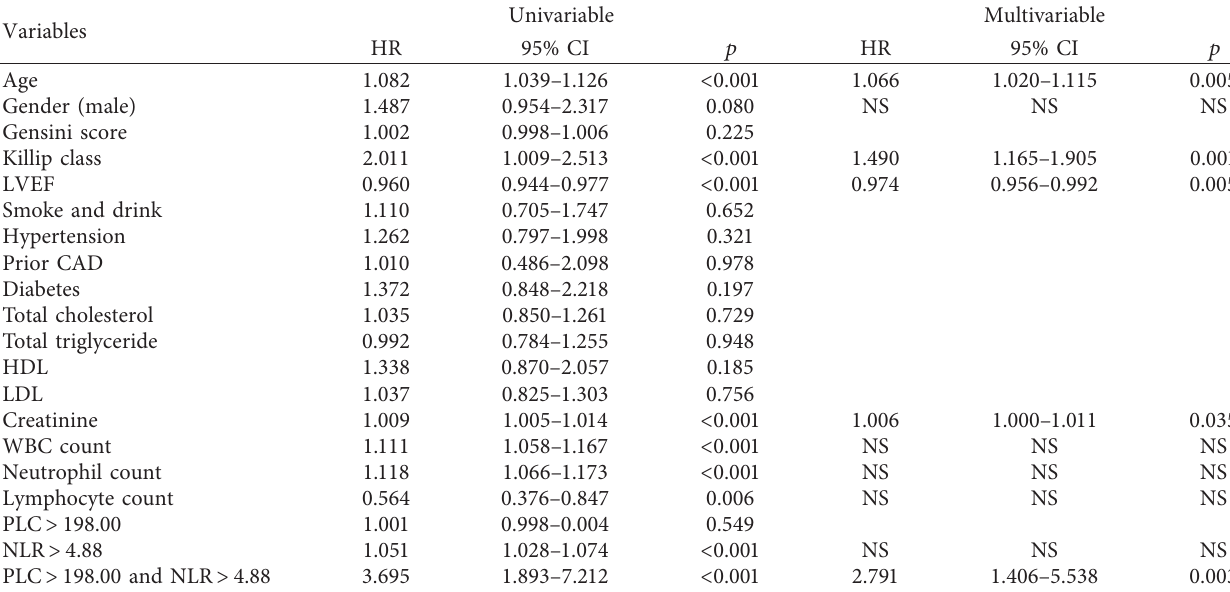
Table 4: Predictors of long-term mortality in univariable and multivariable cox regression